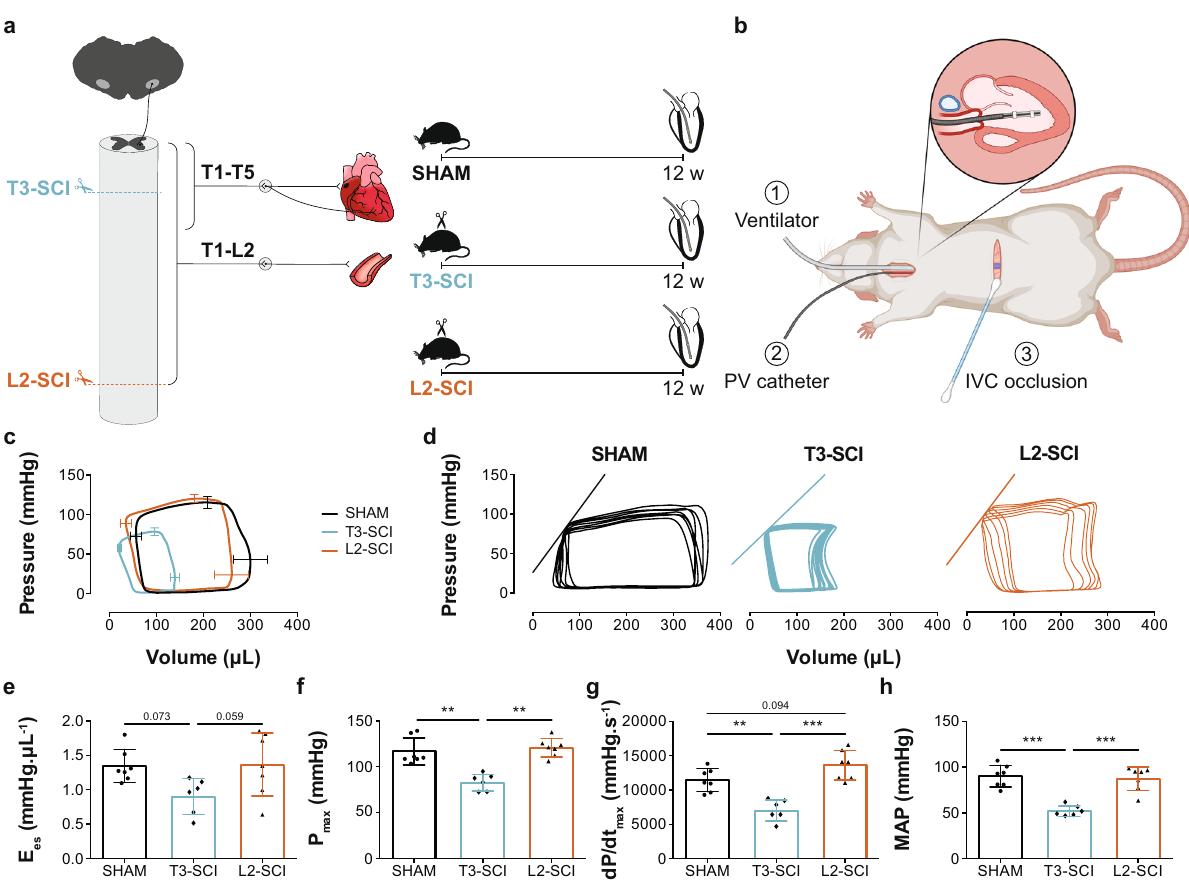
Fig. 7 Effects of level of injury on catheter-derived cardiovascular outcomes in rats with complete transection SCI at the T3 and L2 level (reduced vs. intact bulbospinal sympathetic control). a Methods timeline: Male Wistar rats (10 – 11 wks of age) underwent SHAM injury, T3 complete transection SCI (T3-SCI) or L2 complete transection SCI (L2-SCI). Twelve weeks post-injury, rats underwent catheterization (terminal procedure) to assess hemodynamics and LV function (see Fig. 4 for catheterization details). b Surgical setup at termination, described in Fig. 4 and created with BioRender.com. c Ensemble- averaged pressure-volume loops with bars representing SD. d Representative inferior vena cava (IVC) occlusions with the line representing end-systolic elastance (E es ; index for contractility). e E es ( n = 6 – 7/group) tended to be lower post T3-SCI vs. SHAM or L2-SCI. f Maximum pressure (P max ; n = 6 – 7/ group), g maximal rate of systolic pressure increment (dP/dt max ; n = 6 – 7/group) and h mean arterial pressure (MAP; n = 6 – 7/group) were lower post T3- SCI vs. SHAM or L2-SCI. Data are presented as mean ± SD with individual rats represented as symbols and were analyzed using a one-way ANOVA